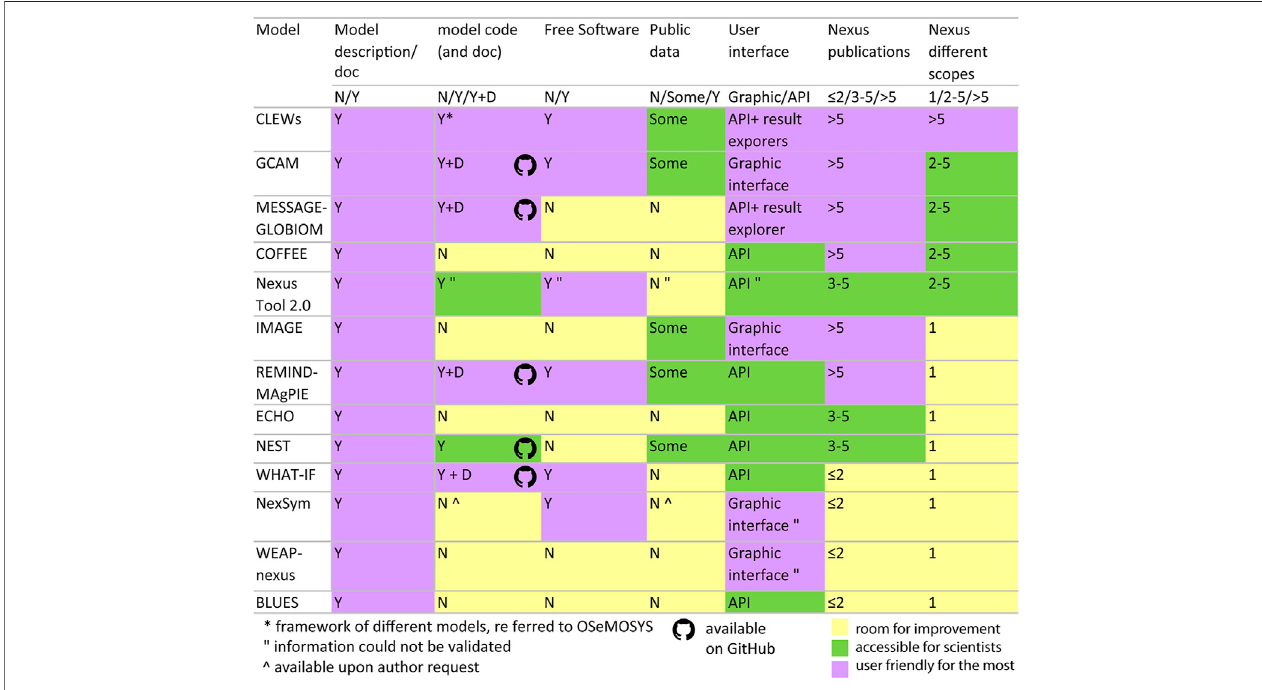
FIGURE 5 | Summary of aspects that de fi ne accessibility of the model, data and software, as well as proxies of previous applications. The colors highlight features that are user-friendly for a generic audience to those requiring more scienti fi c and technical skills.